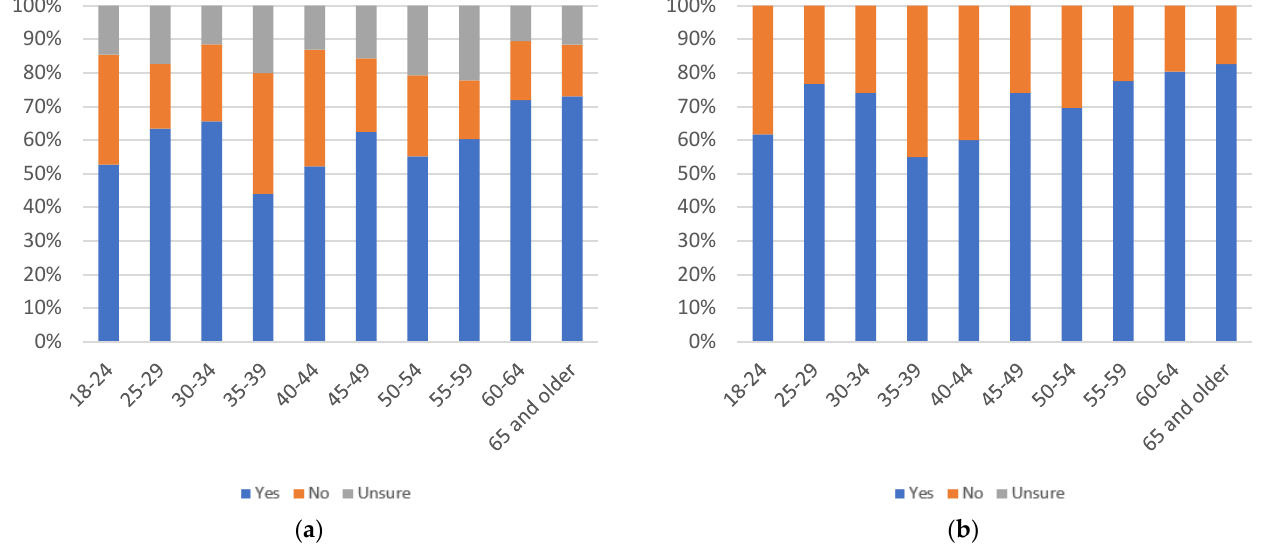
Figure 65. Label trustworthiness judging use, by age group: ( a ) with uncertain respondents (left) and ( b ) without uncertain respondents (right).